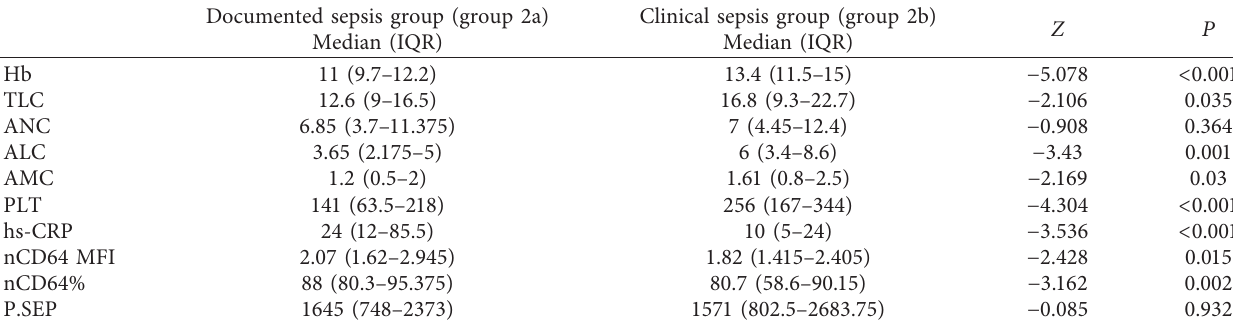
Table 3: Comparison between documented sepsis (group 2a) and clinical sepsis (group 2b).